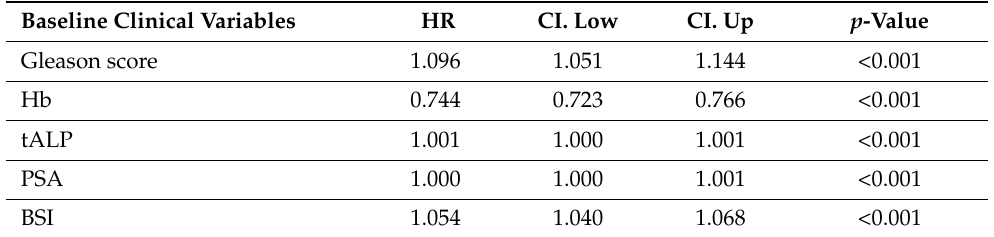
Table 3. Center-adjusted multivariate—cox regression analysis of overall survival (OS) in relation to baseline